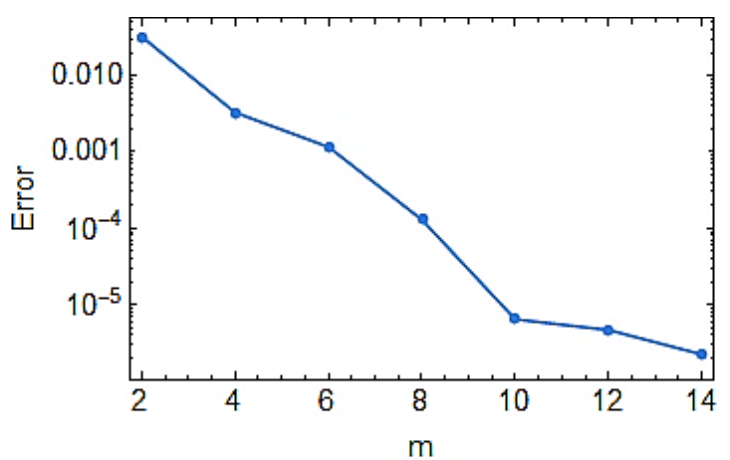
Figure 19. Error of the fluid flow problem at 15th order of HAM when β = 0.5, M = 0.2, Da = 0.5, Rd = 0.3,Pr = 1.0, Ec = 0.1, S = 0.1, Nb = 2.0, Nt = 0.5, Le = 1.0, and λ = 0.5.